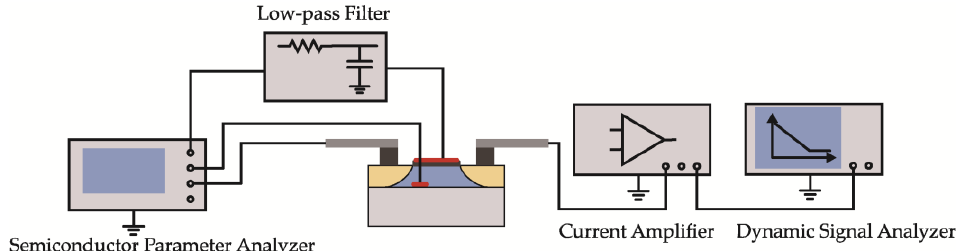
Figure 2. Illustration of the low-frequency noise measurement system.